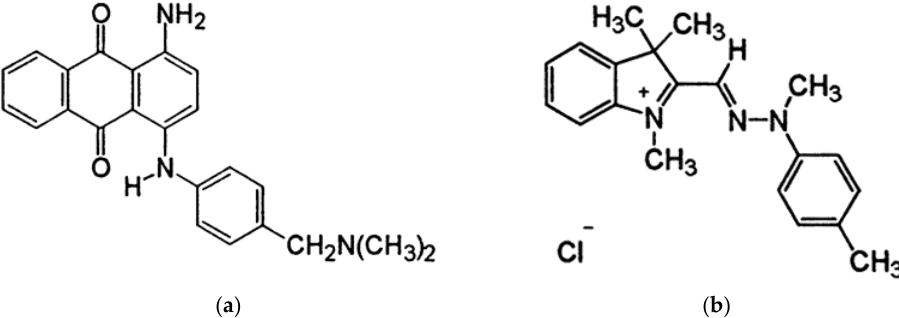
Figure 1. Chemical structure of ( a ) anthraquinone dye C.I. Basic Blue 47 and ( b ) azo dye C.I. Basic Yellow 29.